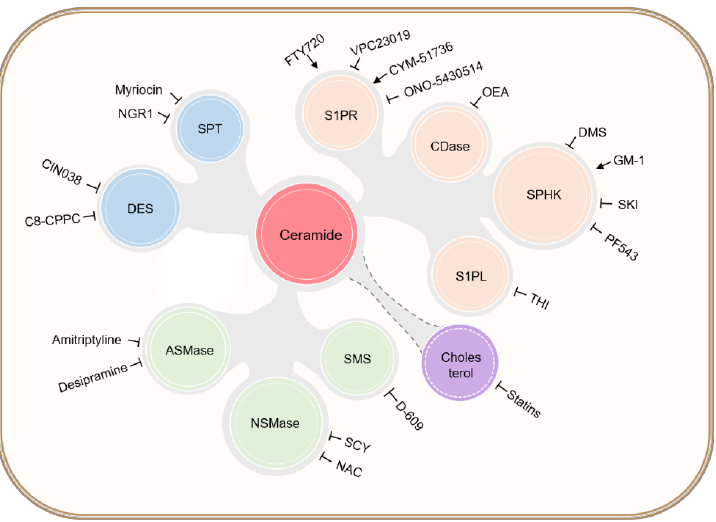
Figure 3. Clinical drugs and bioactive molecules affecting sphingolipid metabolism and their targets. The above drugs can affect sphingolipid metabolism by acting on key enzymes or receptors in the three metabolic pathways. S1PR, S1P receptor; S1PL, S1P lyase; NGR1, notoginsenoside R1; CIN038, 4- ((5-(4-(trifluoromethyl)phenyl)-1,3,4-oxadiazol-2-yl)amino)phenol; C8-CPPC, C8-cyclopro- penylceramide; NAC, N-acetylcysteine; SKI, sphingosine kinase inhibitor; GM-1, monoganglioside; DMS, N,N-dimethylsphingosine; OEA, N-oleoylethanolamine; CYM-51736, N,N-dicyclohexyl-5- (furan-3-yl)isoxazole-3-carboxamide; THI, 2-acetyl-5-tetrahydroxybutyl imidazole.